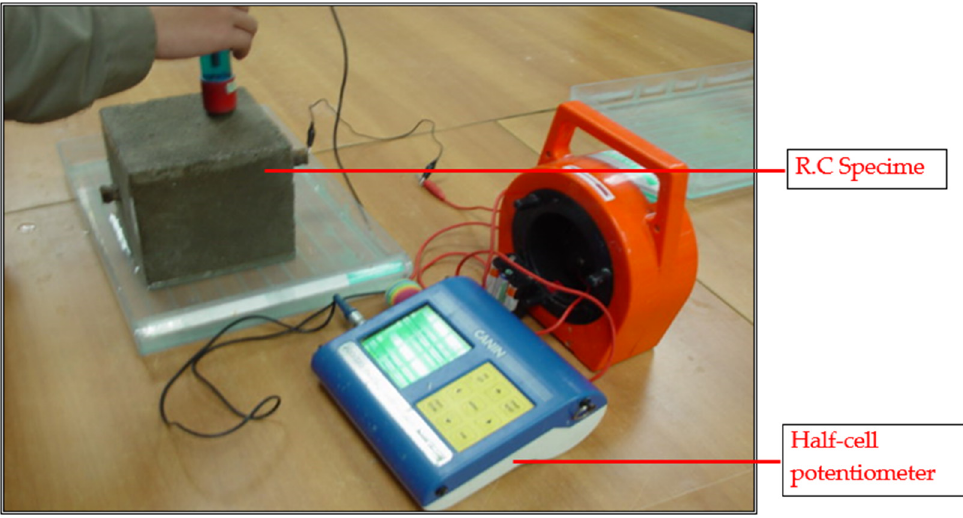
Figure 8. Measurement of Corrosion Voltage.